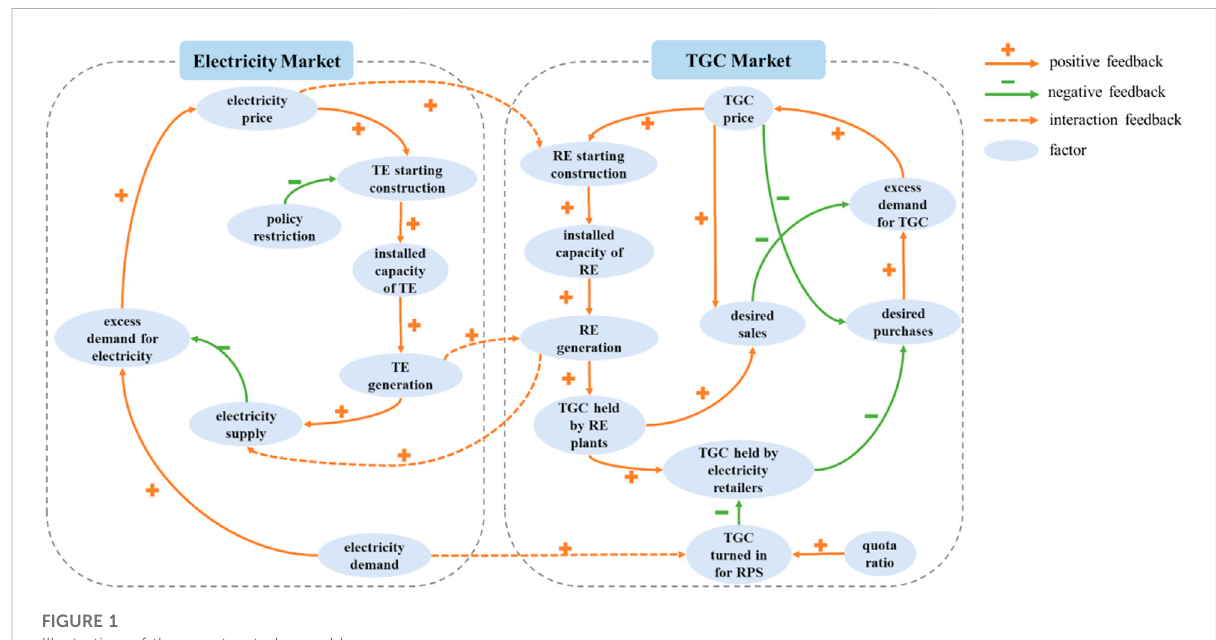
FIGURE 1 Illustration of the constructed causal